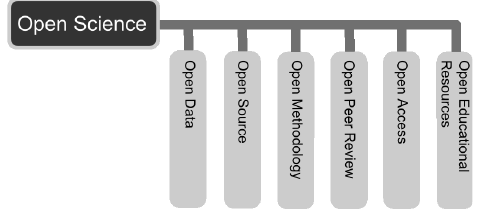
Figure 1. The six components of Open Science: Open Data, Open Source, Open Methodology, Open Peer Review,